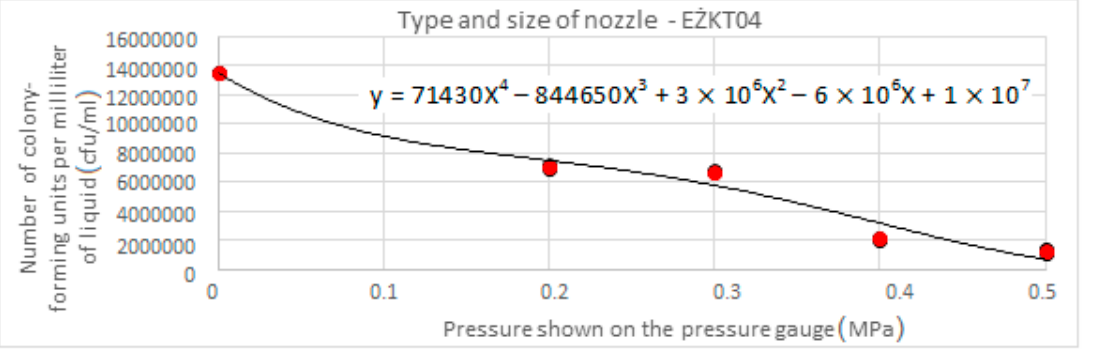
Figure 10. The influence of pressure on survival of cfu/mL of liquid for E Ż KT03.